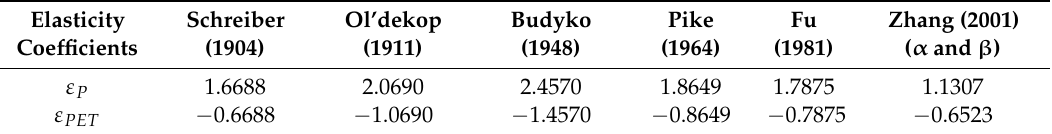
Table 6. Estimated value of elasticity coefficients and Zhang’s coefficients.